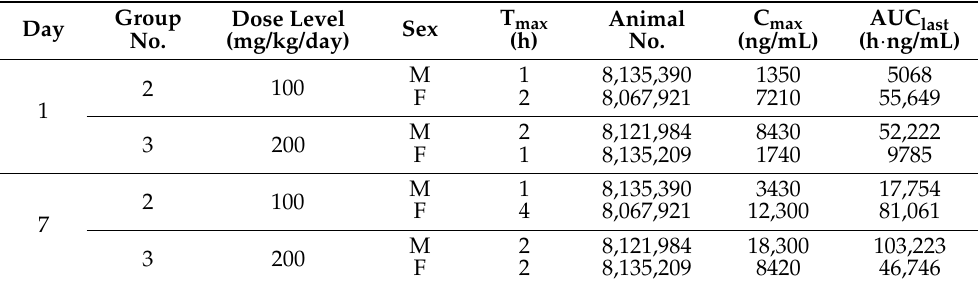
Table 6. ZB716 28-day repeated-dose TK parameters in beagle